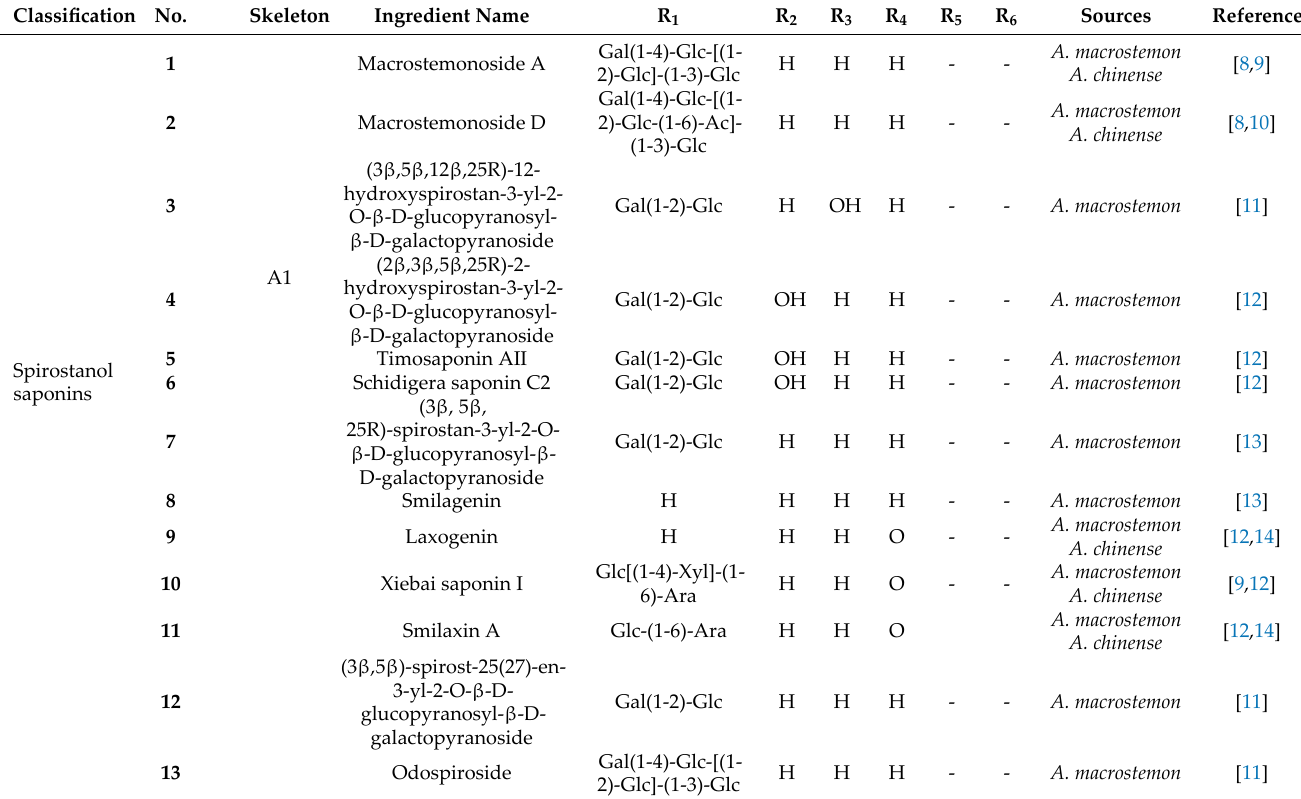
Table 4. List of steroids and steroidal saponins isolated from